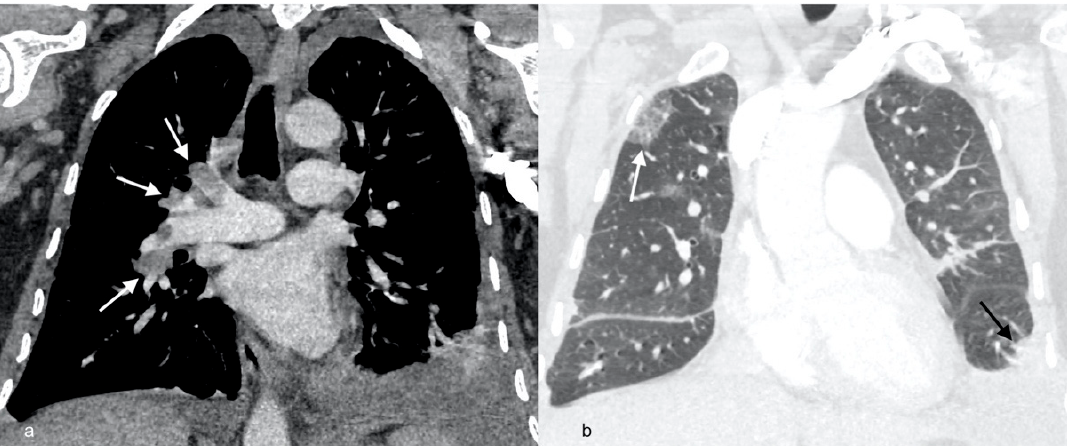
Figure 1. Postero-anterior chest X-ray showing bilateral interstitial infiltrates (white arrows) and left-sided pleural effusion (black arrow).